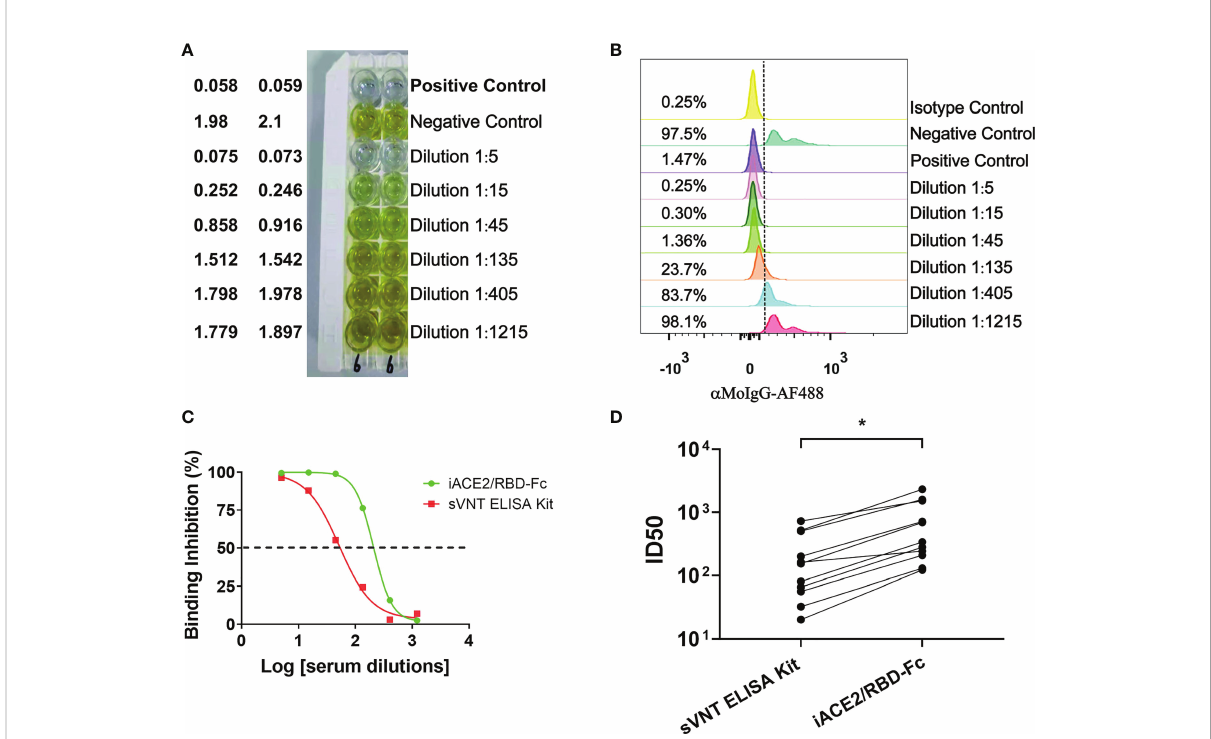
FIGURE 5 Comparison of ID50 values determined by the sVNT ELISA kit and iACE2/RBD-Fc model. ID50 values of 7 vaccine serum samples and 4 convalescent plasma samples were determined by the commercial ELISA based sVNT kit and the iACE2/RBD-Fc model. A panel of raw data for determination of neutralization activity of one vaccine serum by the sVNT ELISA kit and the iACE2/RBD-Fc model was shown in (A, B) , respectively. Two sample dilution response inhibition curves generated from the data shown in Panel (A, B) were plotted and shown in (C) . ID50 values of 11 samples determined by the two assays were compared and shown in (D) . The dash line was used to indicated the serum dilution fold with an activity to inhibit 50% binding of the RBD-Fc on the ACE2 bead. p value <0.05 is represented as